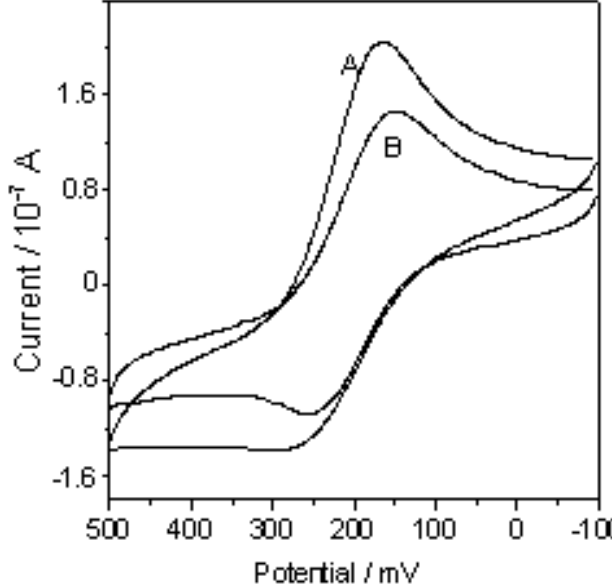
Figure 2. Cyclic voltammograms of 0.4 mM FcPF electrodes at 200 mV s -1